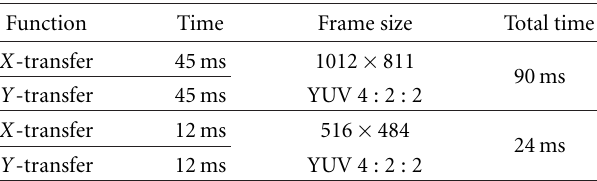
Table 2: The average time needed for the implementation based on the “two 1D transfer steps” idea on a Pentium III